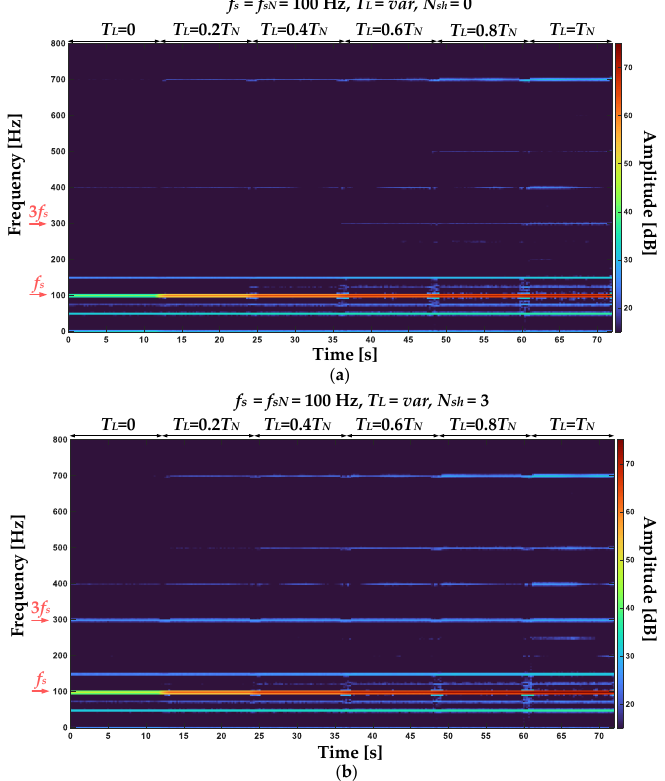
Figure 7. STFT spectrograms of the positive sequence stator current component for ( a ) undamaged stator winding and ( b ) 3 shorted turns in phase A ( T L = var, f s = 100 Hz).